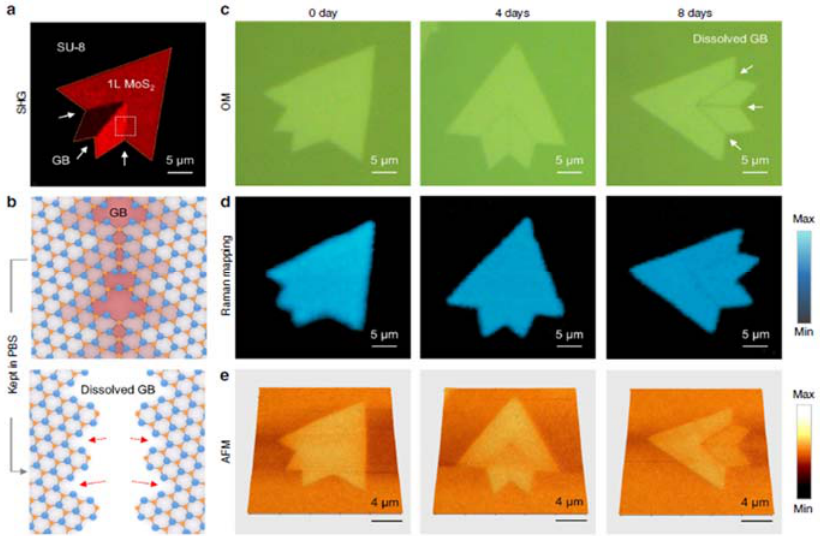
Figure 3. Morphological and structural evolution of isolated monolayer MoS 2 crystals with different dissolution times in phosphate-buffered saline (PBS) solution. An image of an APCVD-grown polycrystalline monolayer MoS 2 crystal on a SU-8/sapphire substrate, showing the distribution regions. ( b ) Schematic illustration of the MoS2 GB marked in the dotted box of ( a ) before and after dissolution in PBS solution. ( c – e ) OM ( c ), Raman A1g intensity mapping ( d ), and atomic force microscopy (AFM) ( e ) images of monolayer MoS 2 crystals, immersed in a PBS solution (pH 7.4) at 75 °C with different dissolution times (0–8 days) [. Reprinted with permission from ref. [71]. 2019 Springer.